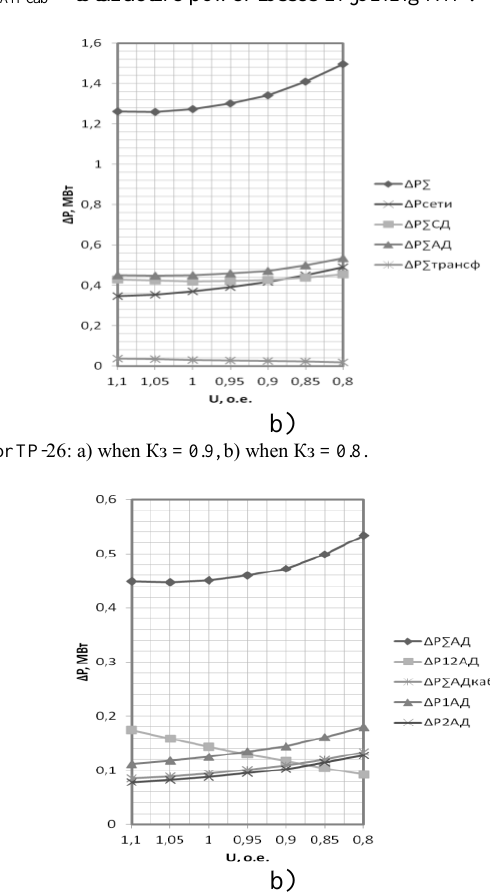
Fig. 3.Statistical characteristics of losses active power in AM: а) when Кз = 0.9 b) when Кз = 0.8.